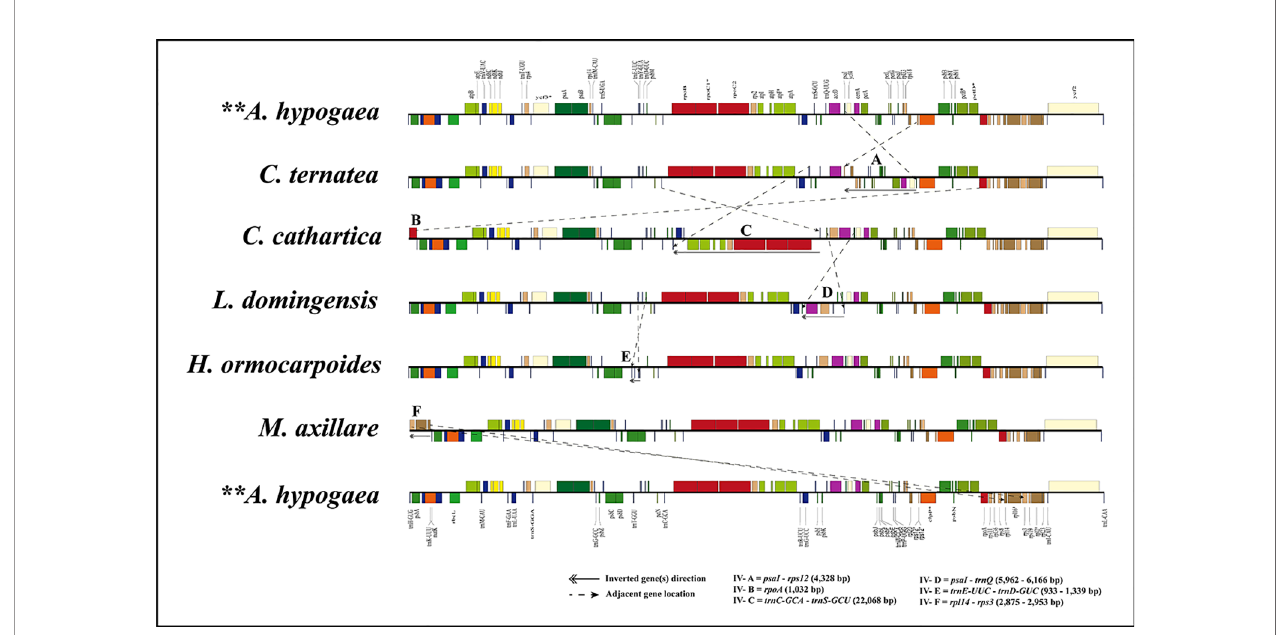
FIGURE 3 | Plastome inversions in representative species of the MP clade. Gene arrangement as the reference plastome of Arachis hypogaea